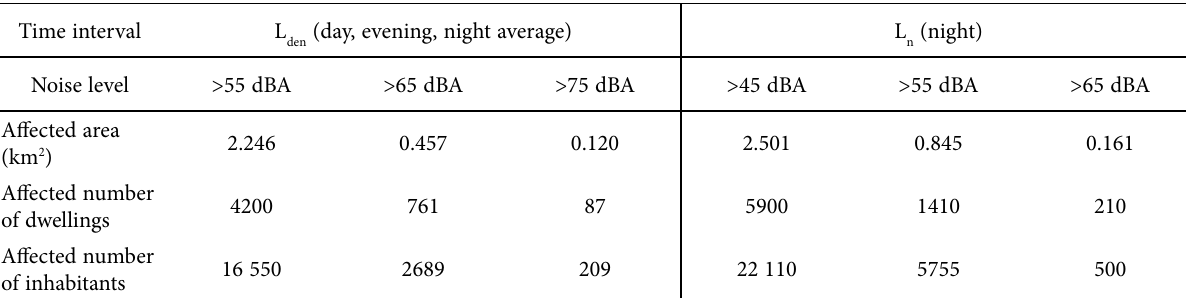
and L for the current situation den n